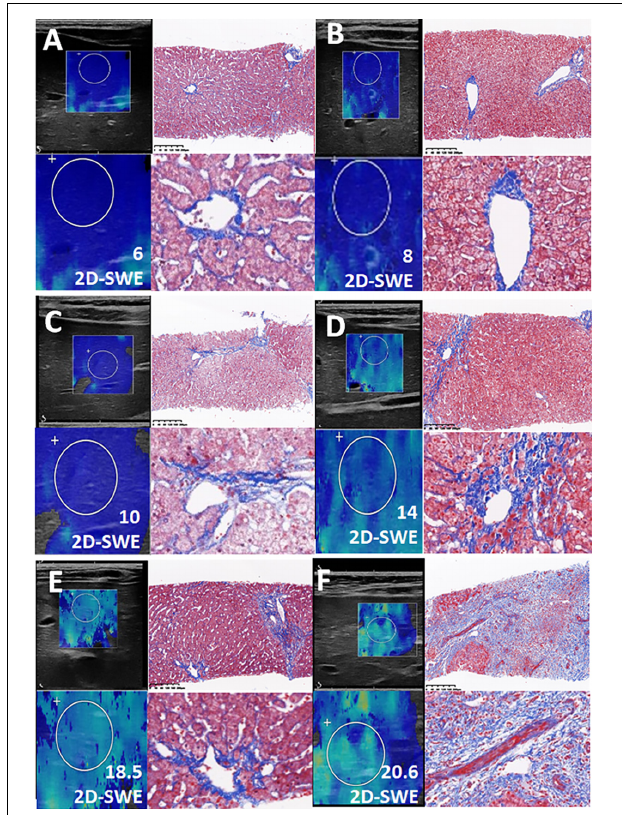
FIGURE 4 | Consistent with the Liver Stiffness Measurements (LSM), the Masson staining of the biopsy was presented in this figure. (A–F) Liver fibrosis with increasing LSM